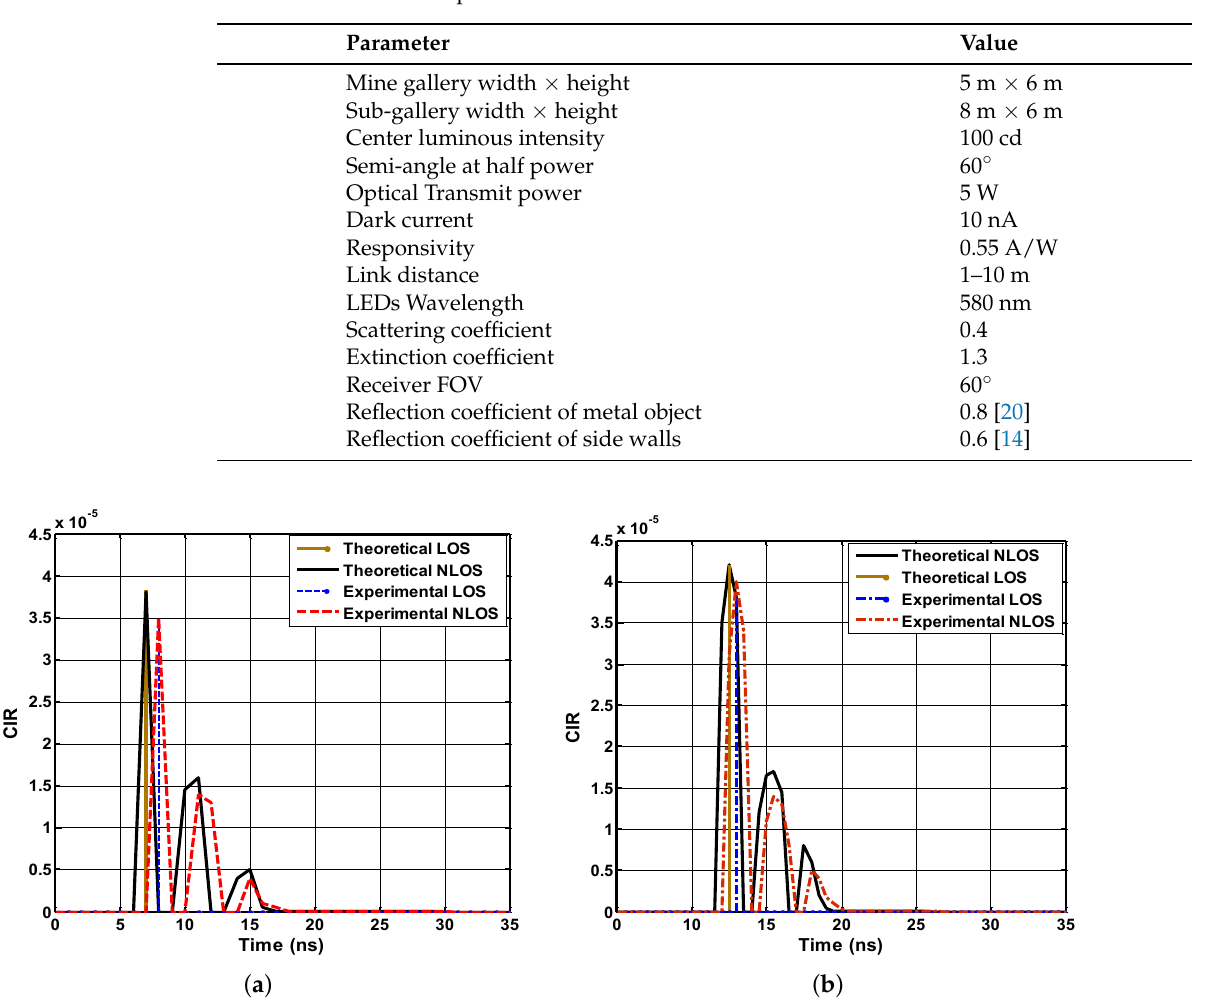
Table 1. The simulation parameters for VLC model.